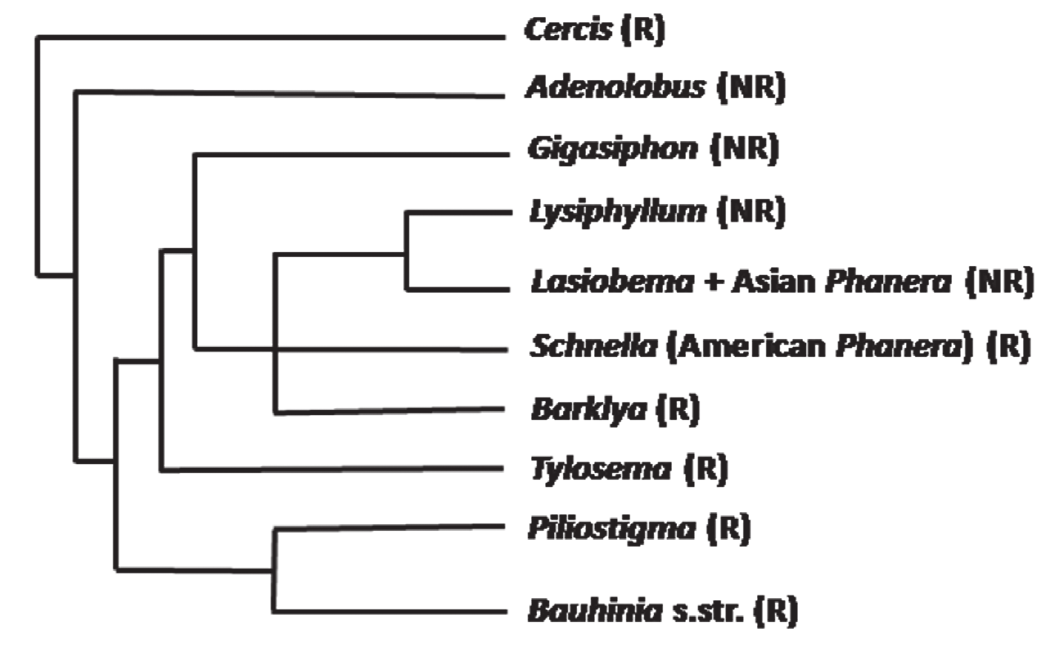
Figure 1 - Simplified phylogenetic relationships among groups of Cercideae, based on Sinou et al. (2009). NR and R: taxa not represented and represented, respectively, in the present work; s. str.: sensu stricto